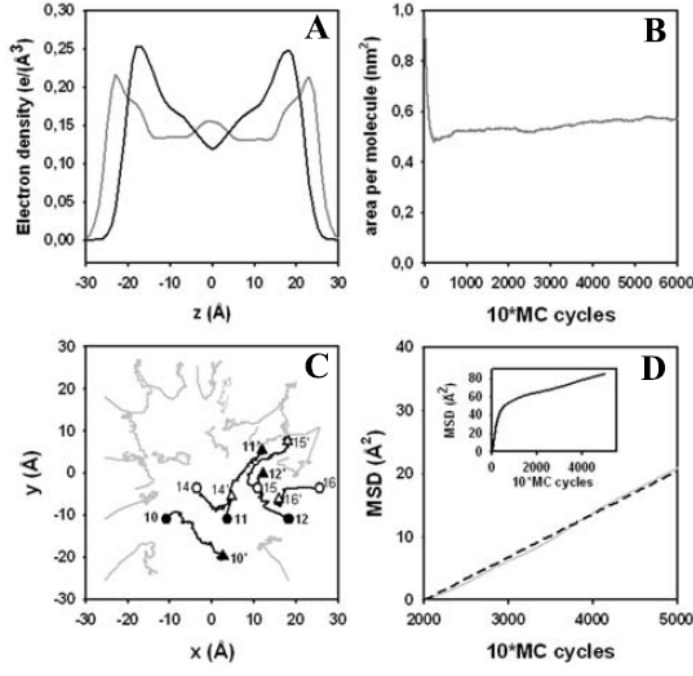
Figure 7. Electron density profile, area per lipid and lateral displacement in the